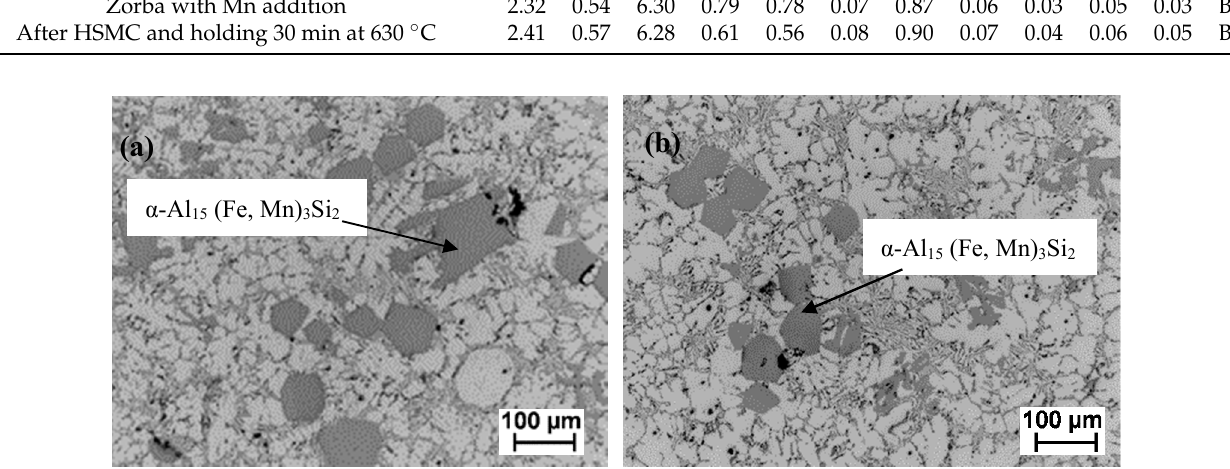
Figure 7. Optical micrographs of modified aluminum alloy recovered from the as-received Zorba cast fraction with 0.8% Mn; ( a ) before de-ironing, ( b ) after HSMC de-ironing.